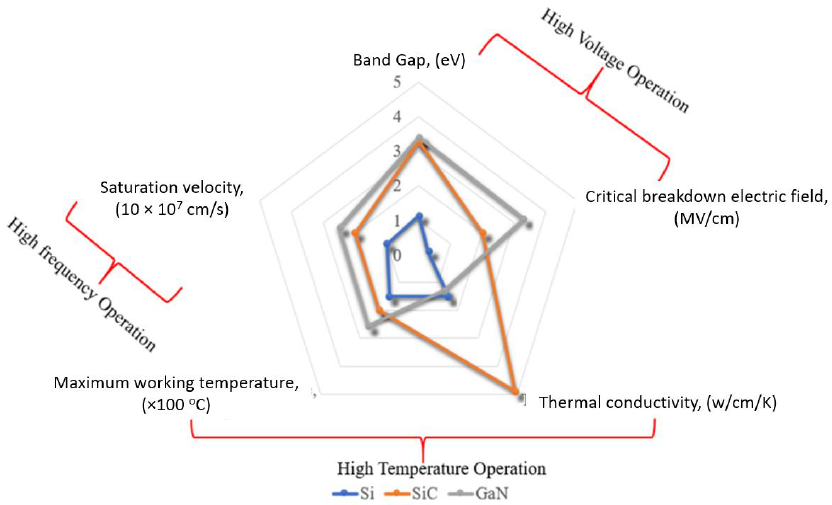
Figure 2. Material characteristics of Si and WBG (SiC and GaN).